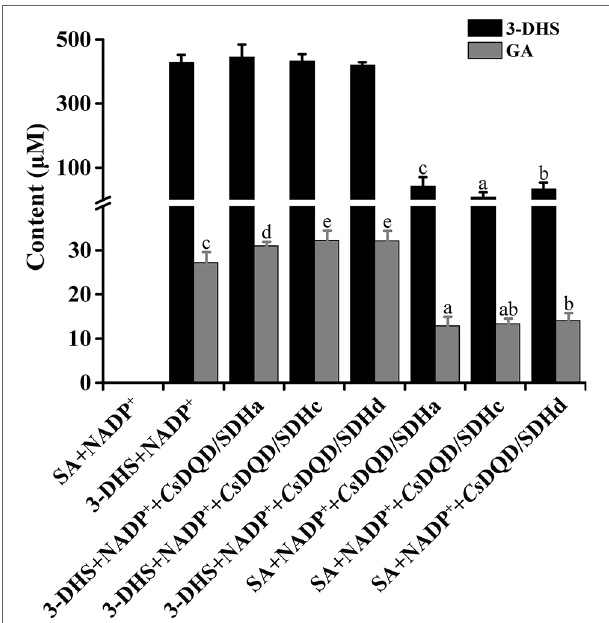
FIGURE 5 | GA generation capacity from Cs DQD/SDHa, Cs DQD/SDHc, and Cs DQD/SDHd and without enzyme as the control. The reaction products in the enzymatic assays were quantified using HPLC ( λ 3-DHS = 234 nm, λ GA = 280 nm). Data are shown as the mean of three replicates ± SD. Different letters represent statistically differ at P < 0.05 according to one-way ANOVA of Duncan’s test. GA, gallic acid; HPLC, high-performance liquid chromatography; ANOVA, analysis of variance.